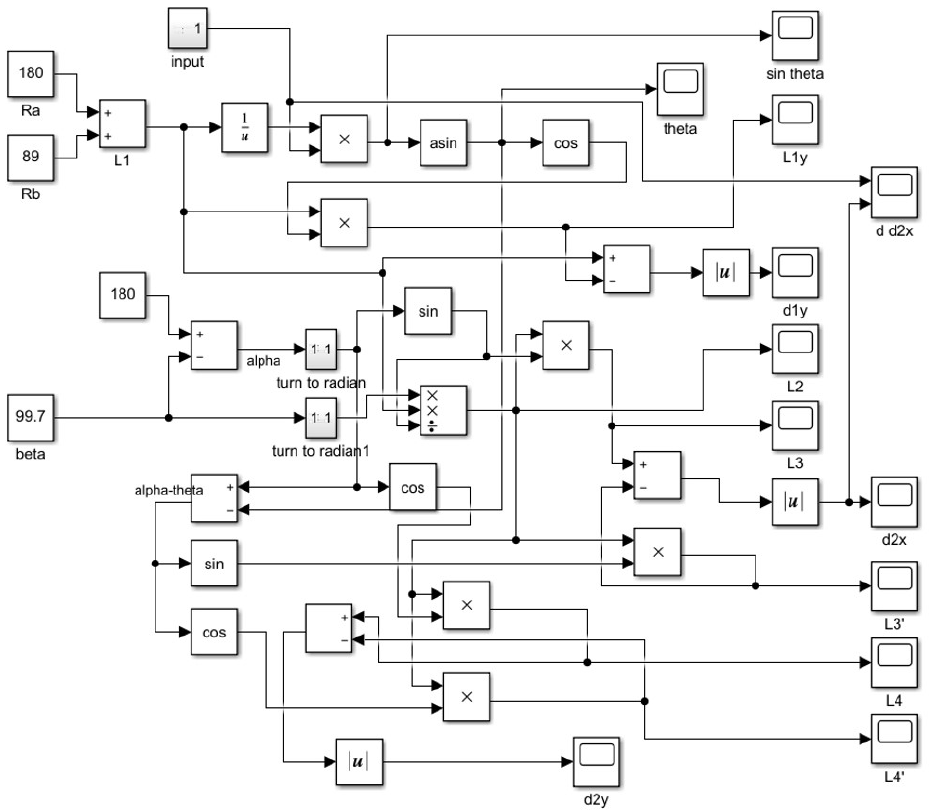
Figure 3. Simulink solving relational model.